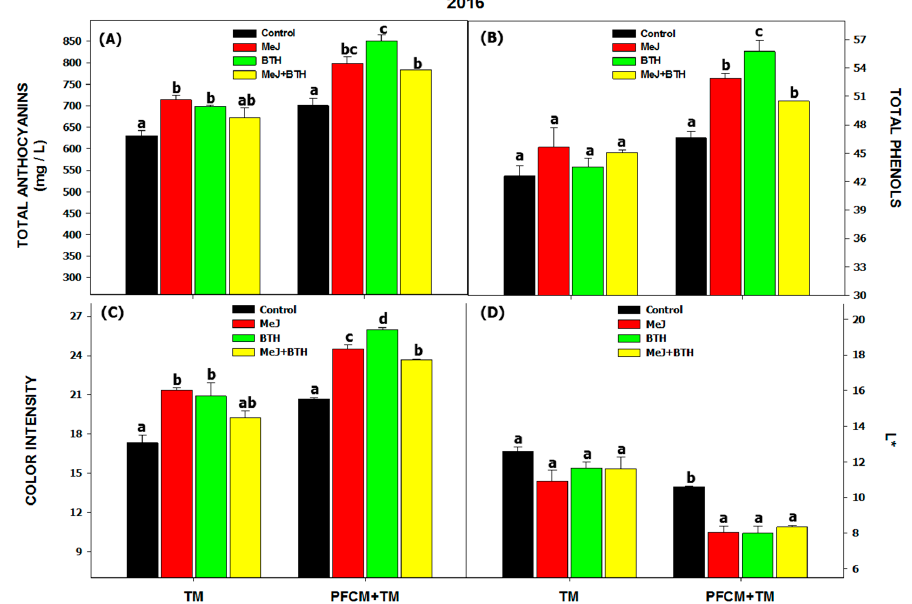
Figure 2. Wine chromatic characteristics in 2016. Total Anthocyanins ( A ), Total Phenols ( B ), Color intensity ( C ), and Luminosity (L*) ( D ). Different letters within the same oenological technique (TM or PFCM + TM) indicate significant differences according to the Duncan test ( p < 0.05). Abbreviations: MEJ: methyl jasmonate; BTH: benzothiadiazole; TM: traditional maceration; PFCM: pre-fermentative cold maceration.